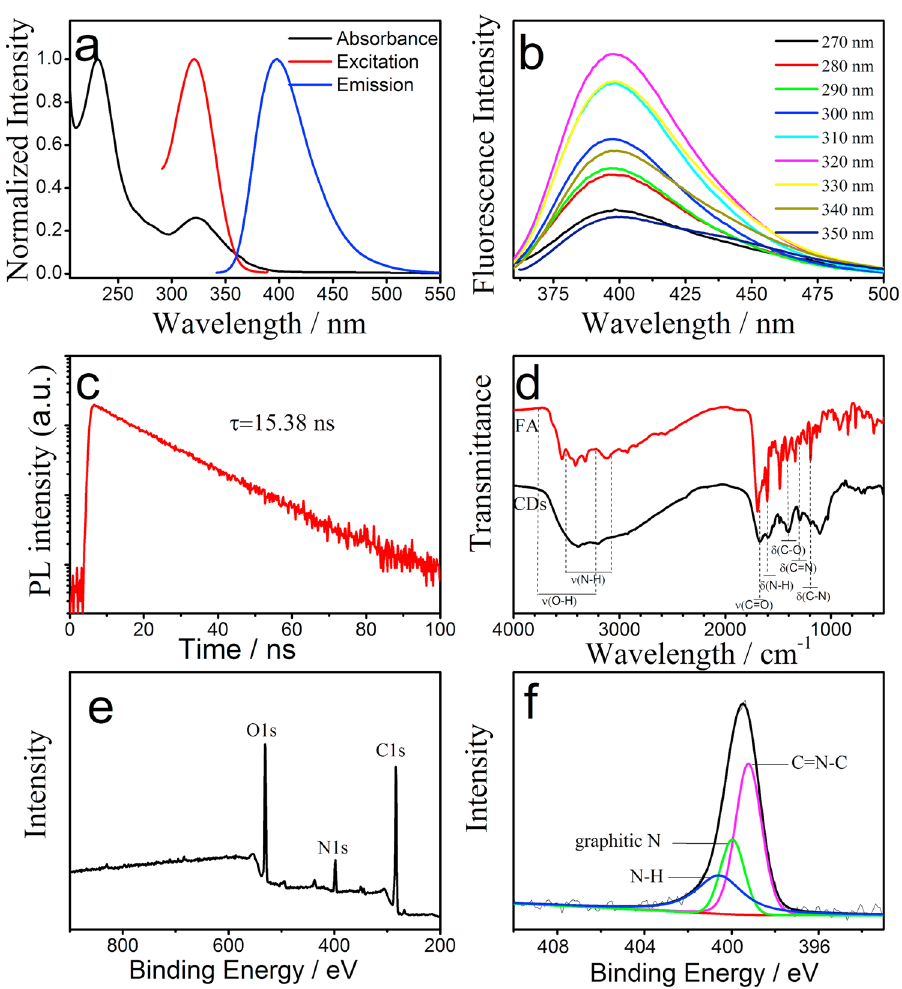
Figure 3. ( a ) UV-vis absorption (black line), PL excitation (red line) and emission (blue line) spectra of the obtained CDs. ( b ) Emission spectra of CDs at different excitation wavelength (start from 270 to 350 nm with a 10 nm increment). ( c ) PL decay curve of CDs. ( d ) FTIR spectra of the precursor (FA, red line) and the prepared CDs (black line). ( e ) XPS spectrum of the prepared CDs. ( f ) High-resolution N1s peaks of the prepared CDs Fig. 1. Schematic illustration of the synthesis of folic acid (FA)-derived CDs and their application for folate receptor (FR)-mediated cancer cell